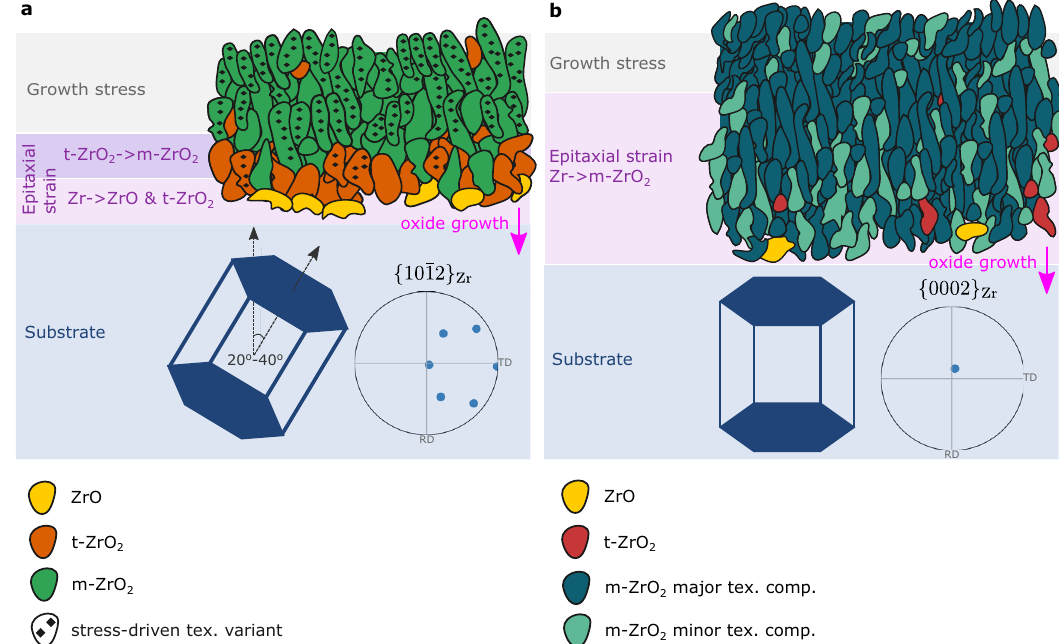
Fig. 7 | Schematic representation of the mechanisms of Zr metal to oxide transformation and their effect on the grain morphology and texture of the oxide fi lm based on the orientation of the substrate metal grain. Two types of oxidemicrostructureareobservedbasedontheorientationofthesubstrategrain. a Region1:aprotectiveoxidelayerwithlongcolumnargrainsandlowenergygrain boundaries under the in fl uence of the growth stress. b Region 2: less protective